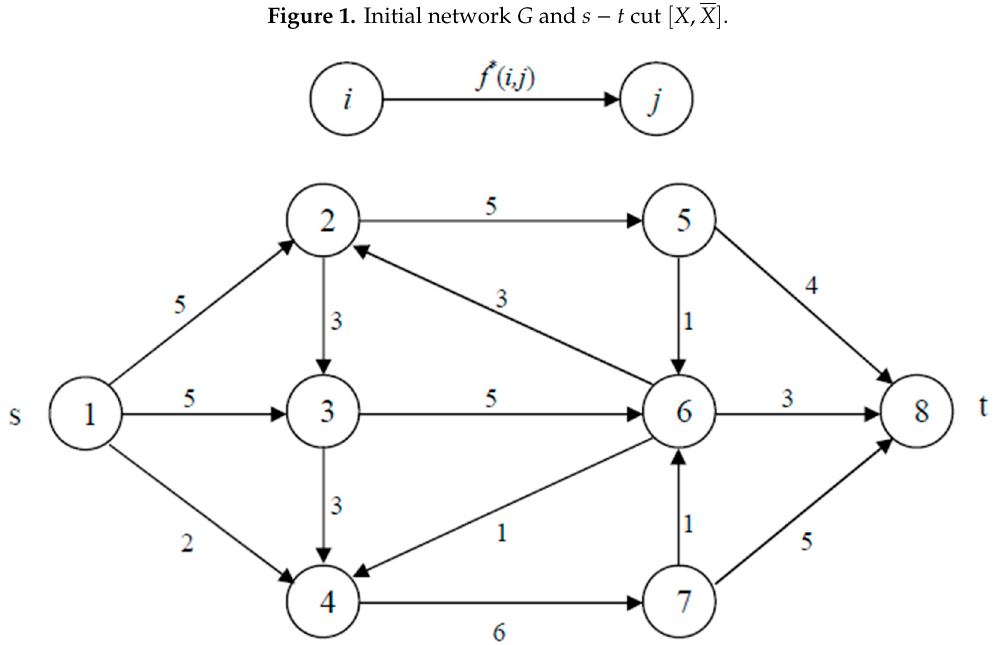
Figure 1. Initial network G and s-t cut [X,X ̅ ].